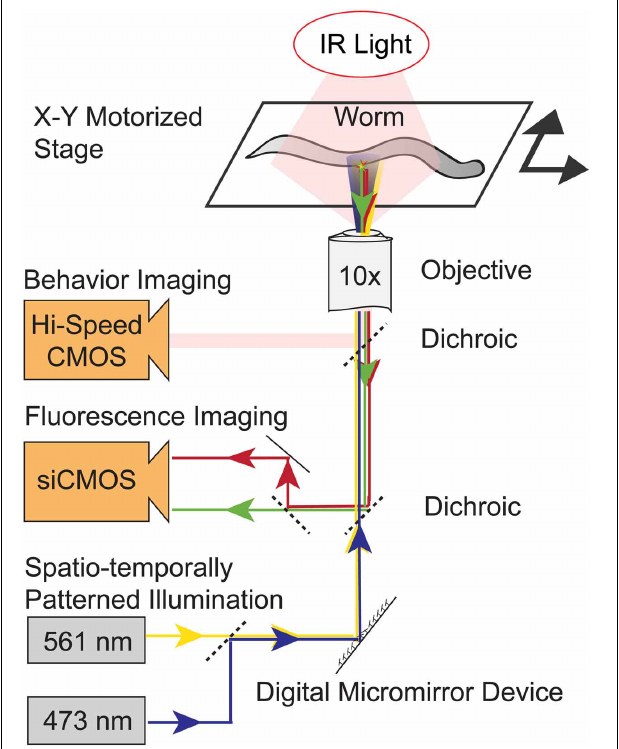
FIGURE 1 | Schematic of the illumination and imaging systems. A worm moves freely on a motorized stage under infrared illumination (IR). A digital micromirror device (DMD) reflects blue and yellow laser light onto only targeted neurons. Three separate imaging paths simultaneously image the worm’s behavior and record simultaneous red and green fluorescence images. Real-time computer vision software monitors the worm’s posture and location and controls the DMD, lasers and stage. The DMD’s illumination pattern is continuously updated to illuminate only targeted